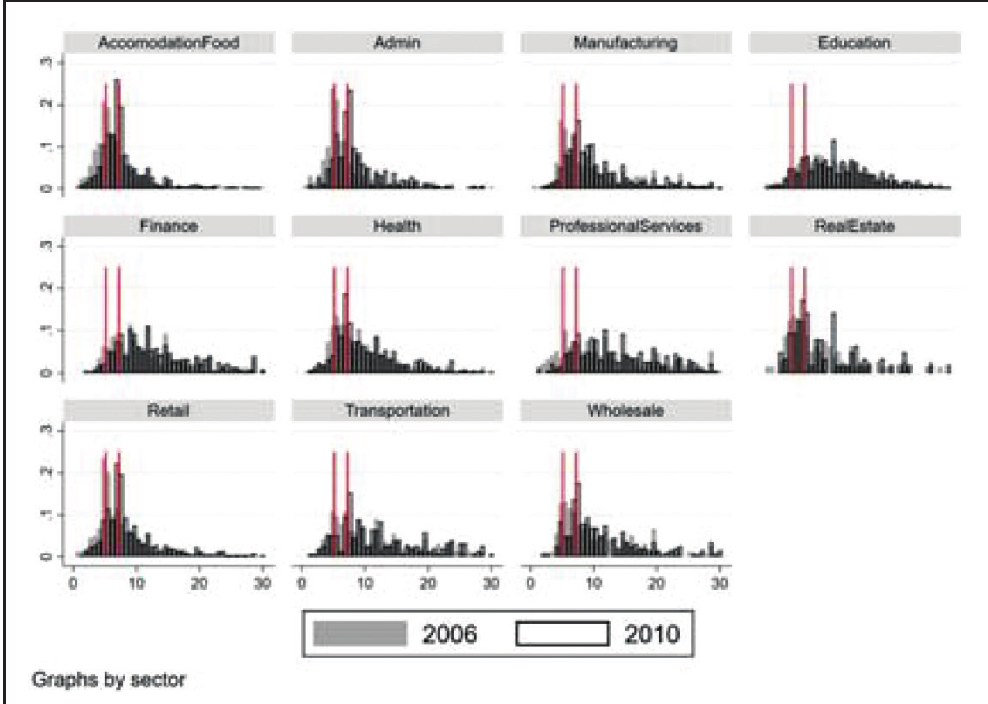
Figure 8 Bite of the Minimum Wage Across Puerto Rican Industries.